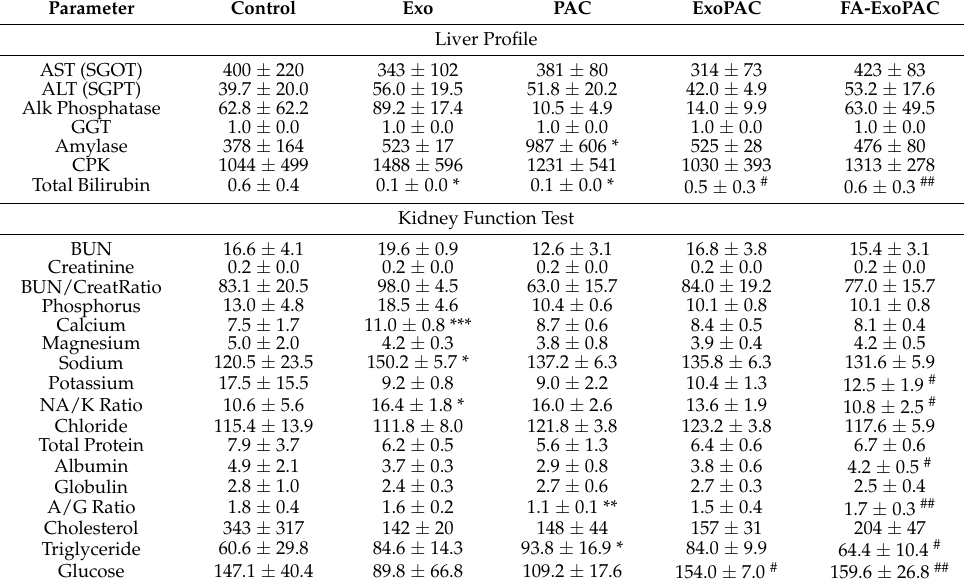
Table 1. Effect on biochemical profile (systemic toxicity) following 28 days exposure to Exo, PAC and ExoPAC in C57BL/6 mice.